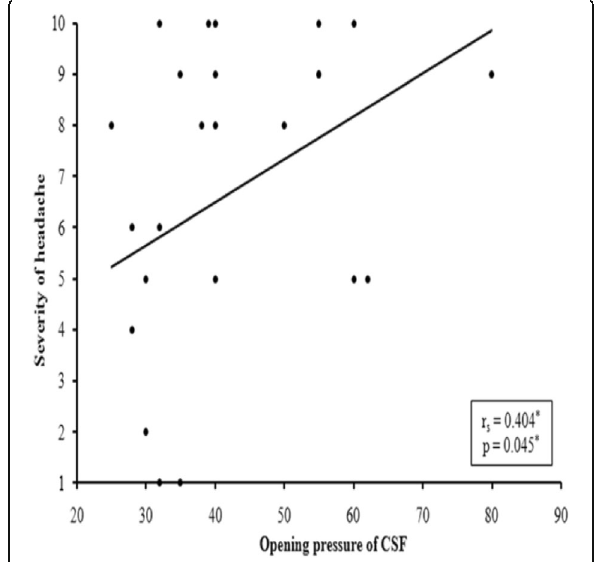
Fig. 3 Correlation between opening pressure of CSF with severity of headache ( n = 25)